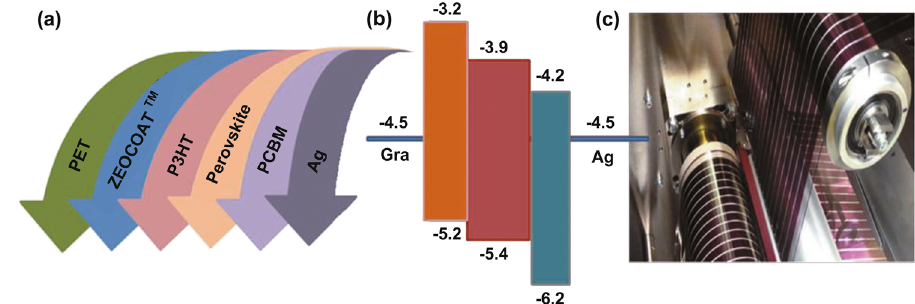
Fig. 17 Roll-to-roll fabrication of perovskite photovoltaic sheets